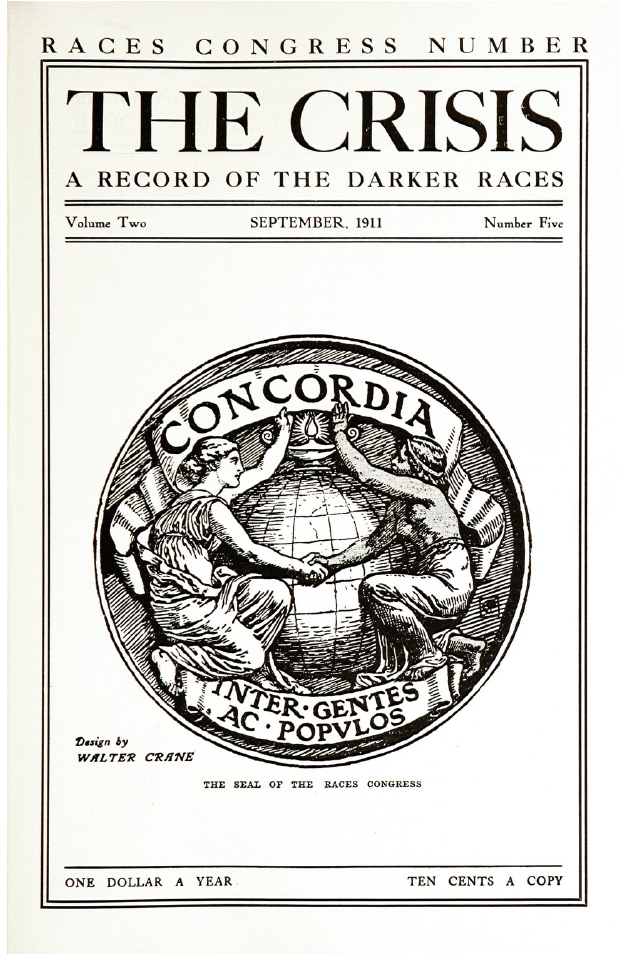
Cover of the Crisis , Races Congress Number (September